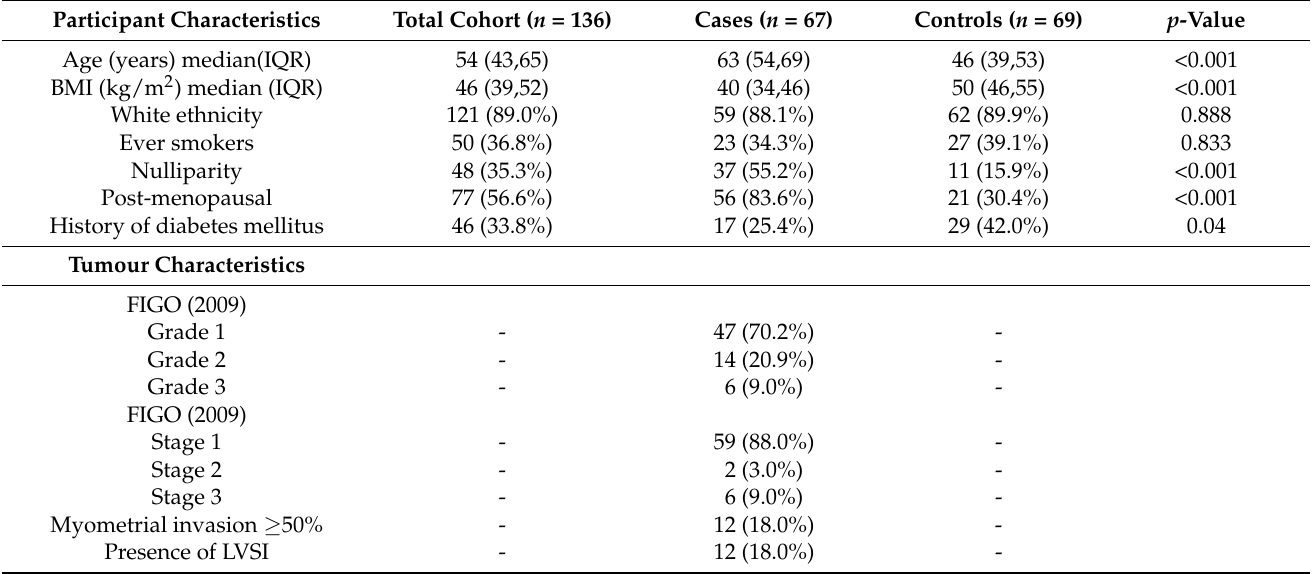
Table 1. Clinicopathological characteristics of the